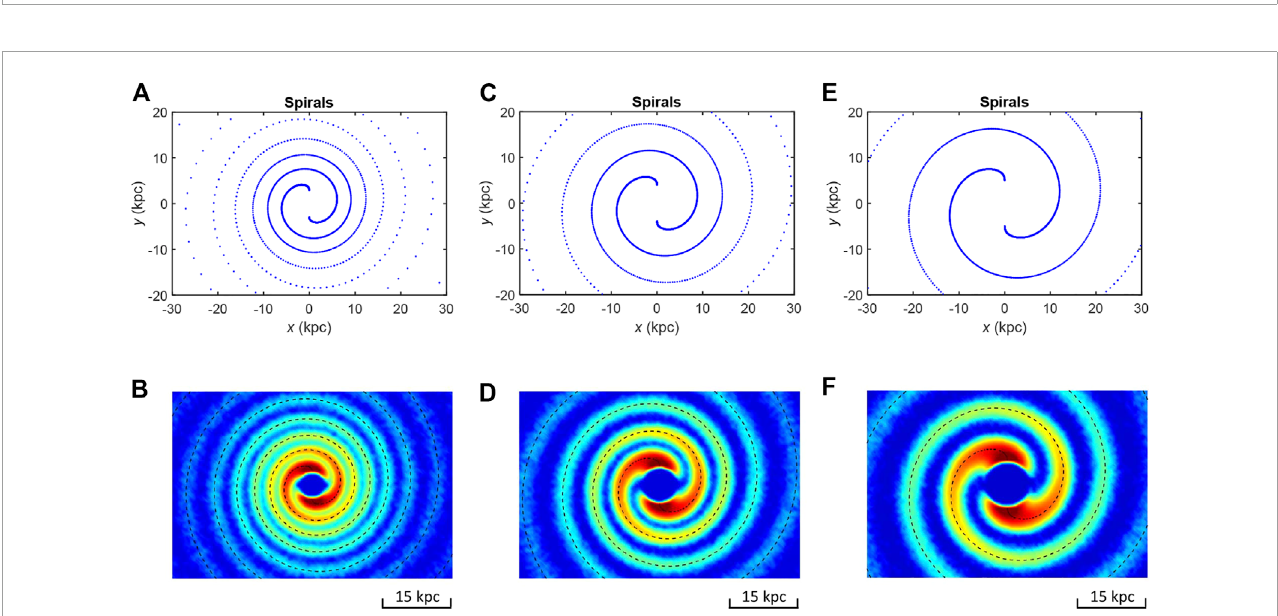
FIGURE 5 Geometry of spirals: dependence on the initial size of the bulge-bar region. The age of the galaxy is 8.8 Gyr and the maximum redshift is z = 11 . 2. The upper/lower plots show orbits with unperturbed/perturbed parameters R c and ϕ . The critical radius R c and the rotation velocity V ϕ are 3 kpc and 218.3 km/s in (A, B) , 4 kpc and 217.7 km/s in (C, D) , and 5 kpc and 215.2 km/s in (E, F) . The masses of the bulge and disk are M b = 8.5 × 10 9 M ⊙ and M d = 8.5 × 10 10 M ⊙ ,